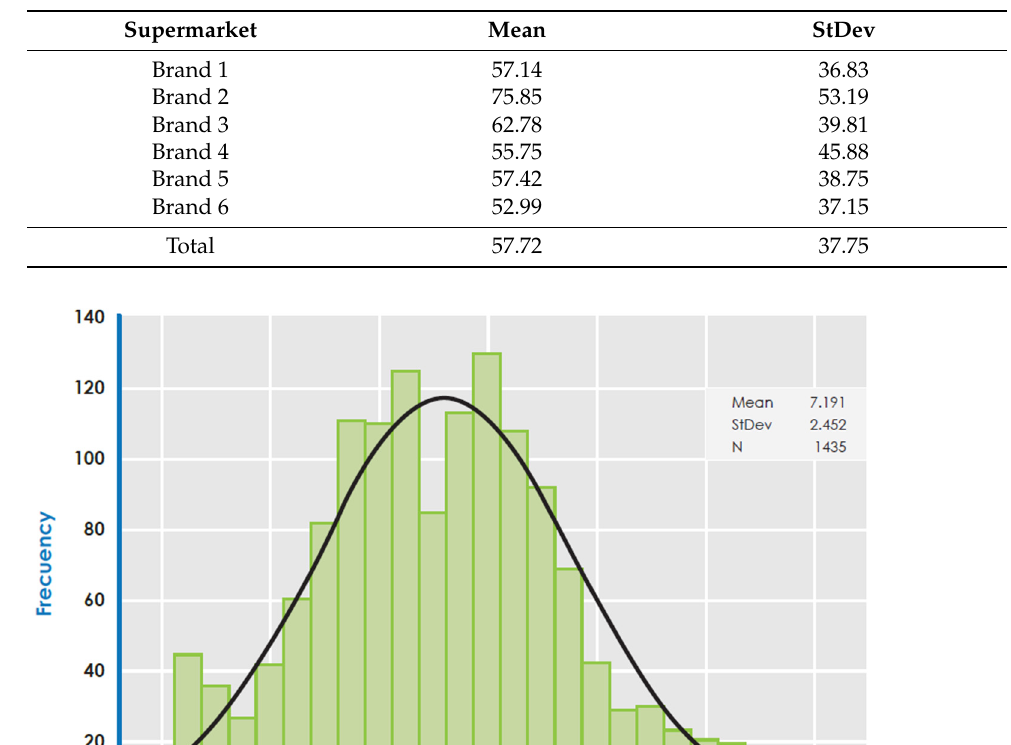
Table 2. Statistical data of supermarket-type customers.